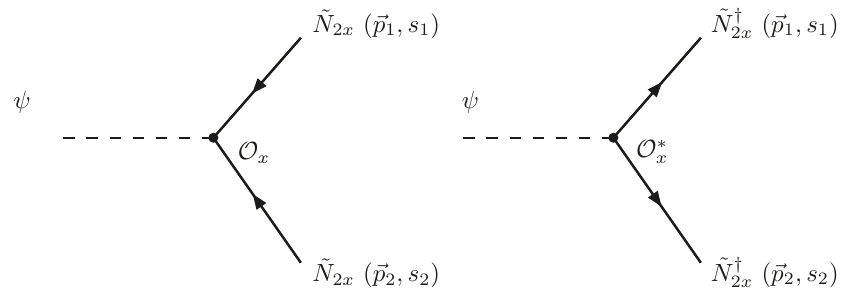
Figure 24. Feynman diagrams which contribute to the processes